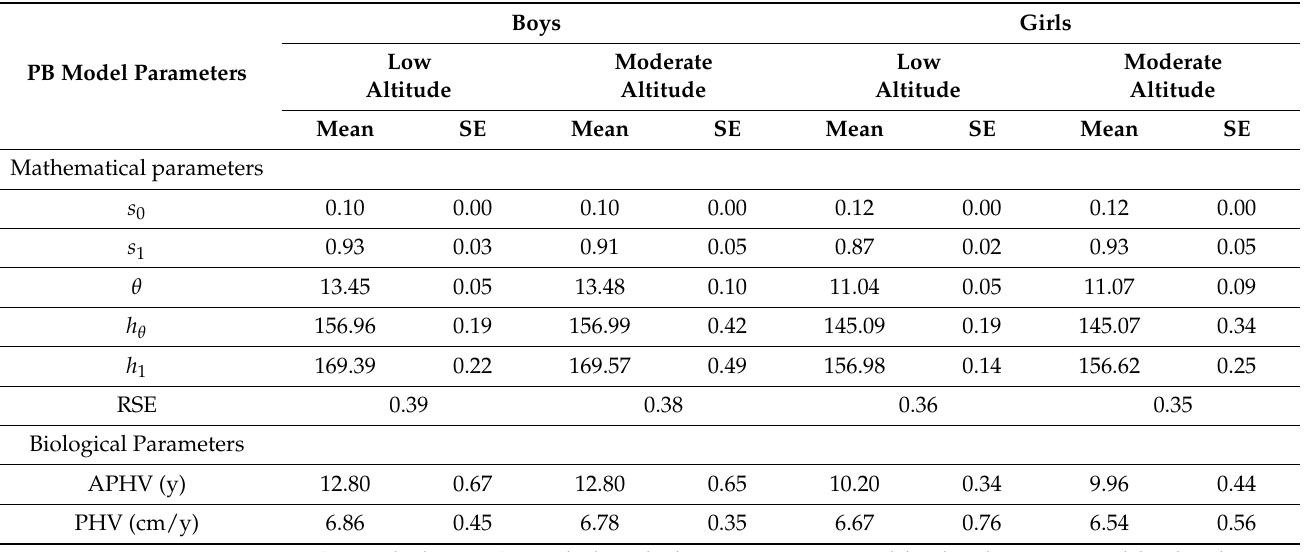
Table 2. Mathematical and biological parameters of height, estimated by 1 Preece–Baines (1PB) model according to sex and altitude groups.